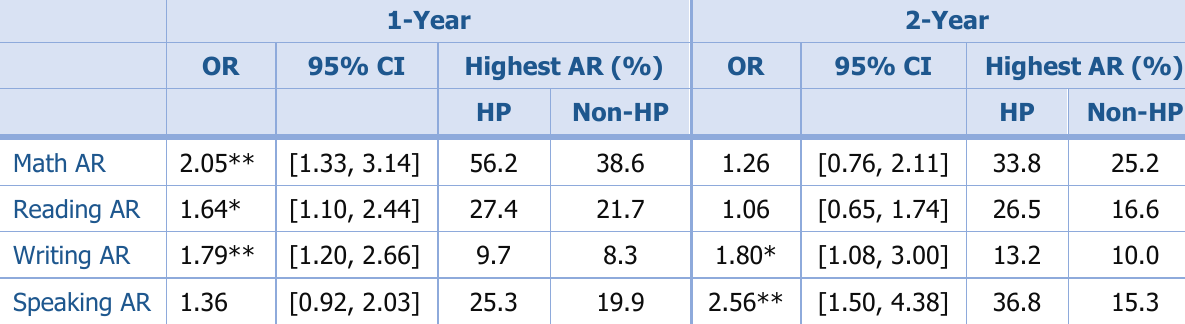
Table 4. Achievement Rating Outcomes of 1-Year and 2-Year Samples of Harmony and Non-Harmony